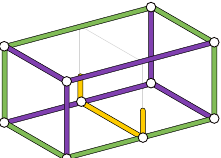
FIG. 15. The measurement pattern and check operator of a FBQC twist defect. Purple and green edges represent XX and ZZ operators. Yellow full and half edges represent YY and Y opera- tors. The YY operator is obtained as the product of XX and ZZ measurements of the given